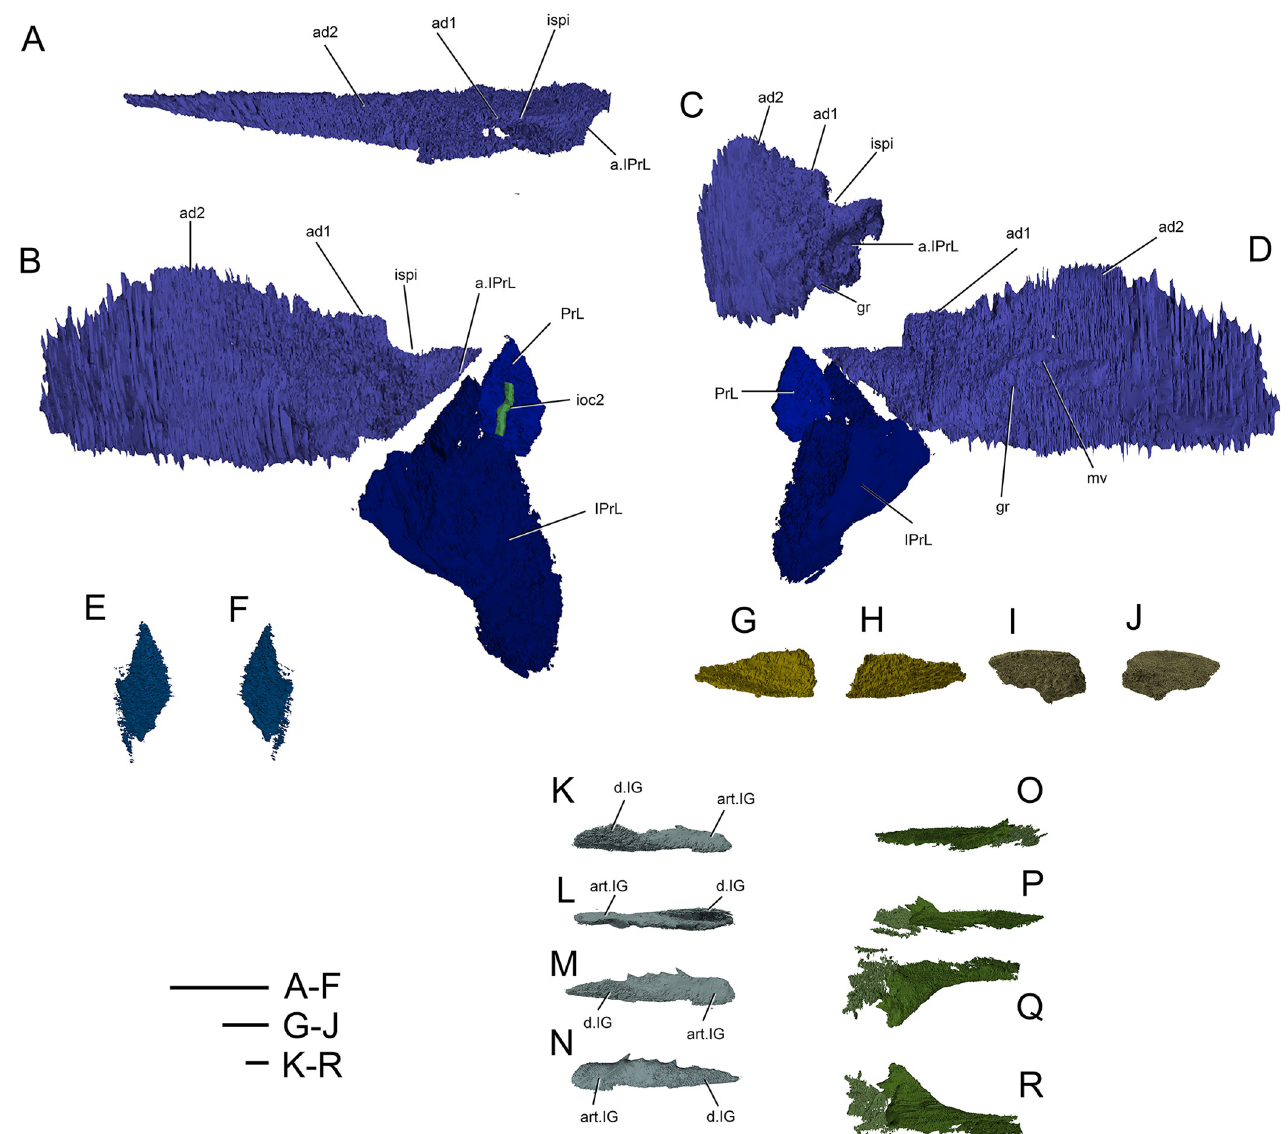
Fig 5. Bothriolepis dairbhrensis sp. nov. Opercular and mouth elements. A-D. right submarginal plate in dorsal (A) and anterior (C) views, with prelateral and infra-prelateral plates restored in anatomical position in anterolateral (B) and posteromesial (D) views. E-F, left prelateral plates in lateral (E) and mesial (F) views. G-J. Suborbital plates (G, right suborbital in internal view, H in external view; I, right suborbital plate in external view, J in internal view). K-R, infragnathal plates (K, left infragnathal in anterior view, L in posterior view, M in dorsal view, N in ventral view; O, right infragnathal in anterior view, P, in posterior view, Q in dorsal view, R in ventral view). Images generated with Materialise 3-matic, v. 13.0. Scale bars 10 mm.